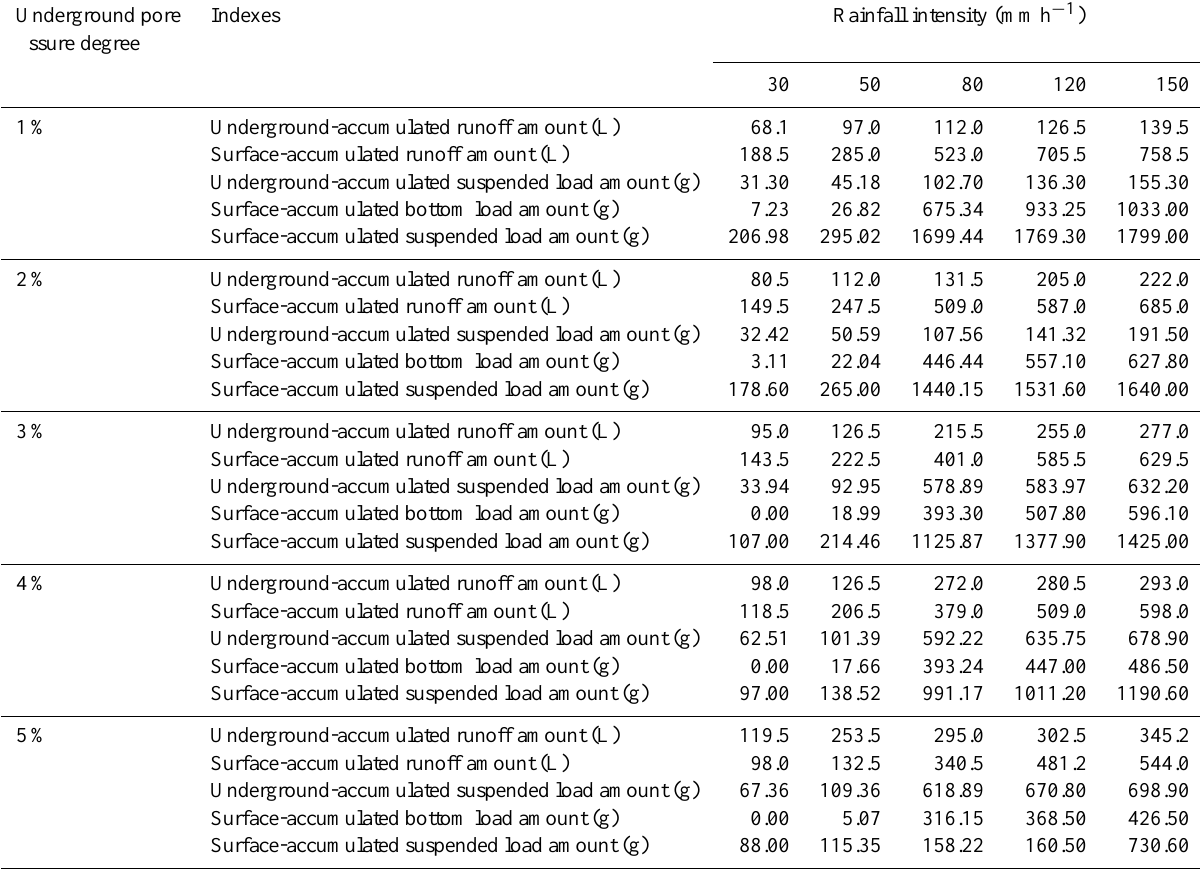
Table 4. Degrees of holes and fissures on the impact of runoff and sediment production. Underground pore